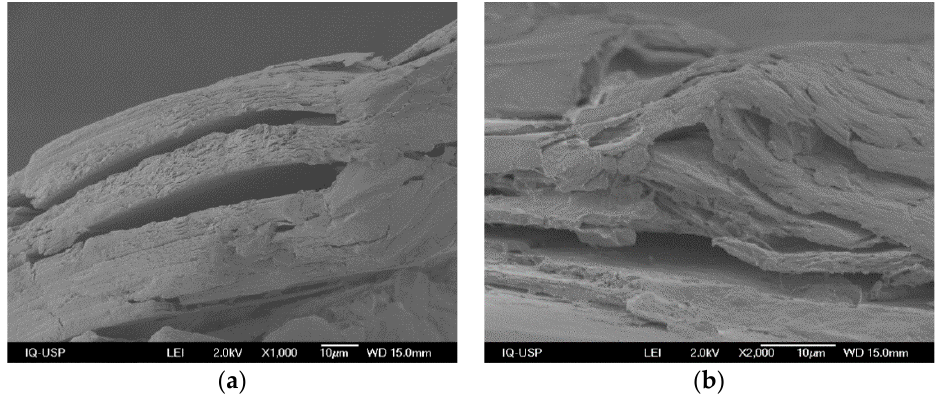
Figure 3. Scanning electron microscopy of ( a ) Na-Vt and ( b ) FeOH-Vt.